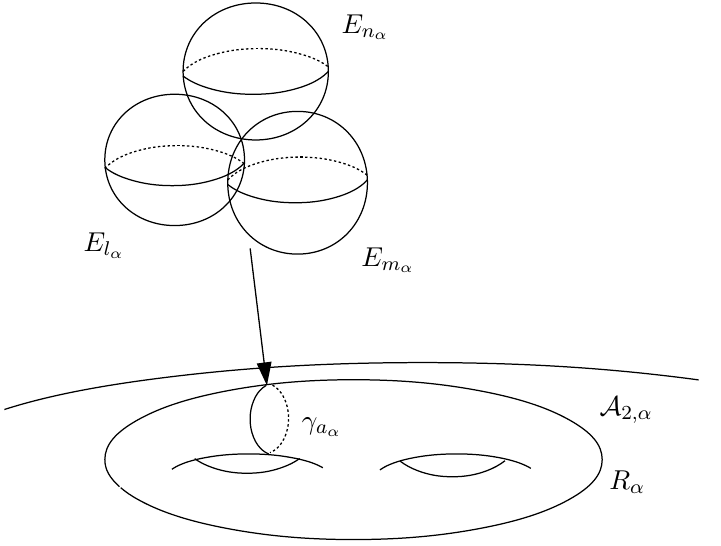
Figure 1 . Intersection structure of the divisors D ′ l holomorphic one-forms γ a